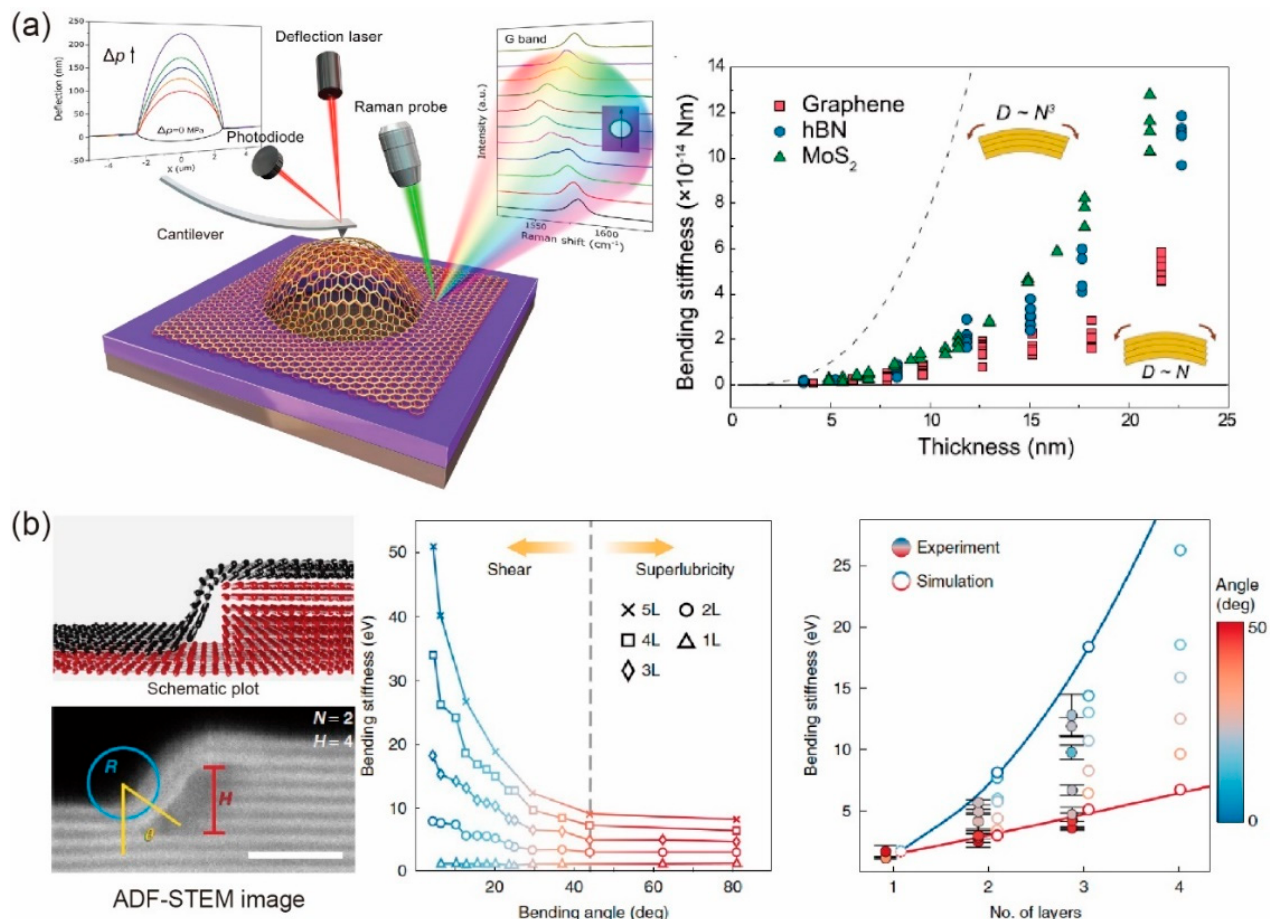
Figure 7. Bending behaviors of multilayer graphene. ( a ) Direct measurements of bending rigidity of multilayer graphene, molybdenum disulfide (MoS2), and hexagonal boron nitride (hBN) based on pressurized bubbles. Reprinted with permission from [111,112]. ( b ) Measurements and results of bending rigidity of multilayer graphene as a function of bending angle. Reprinted with permission from [30].